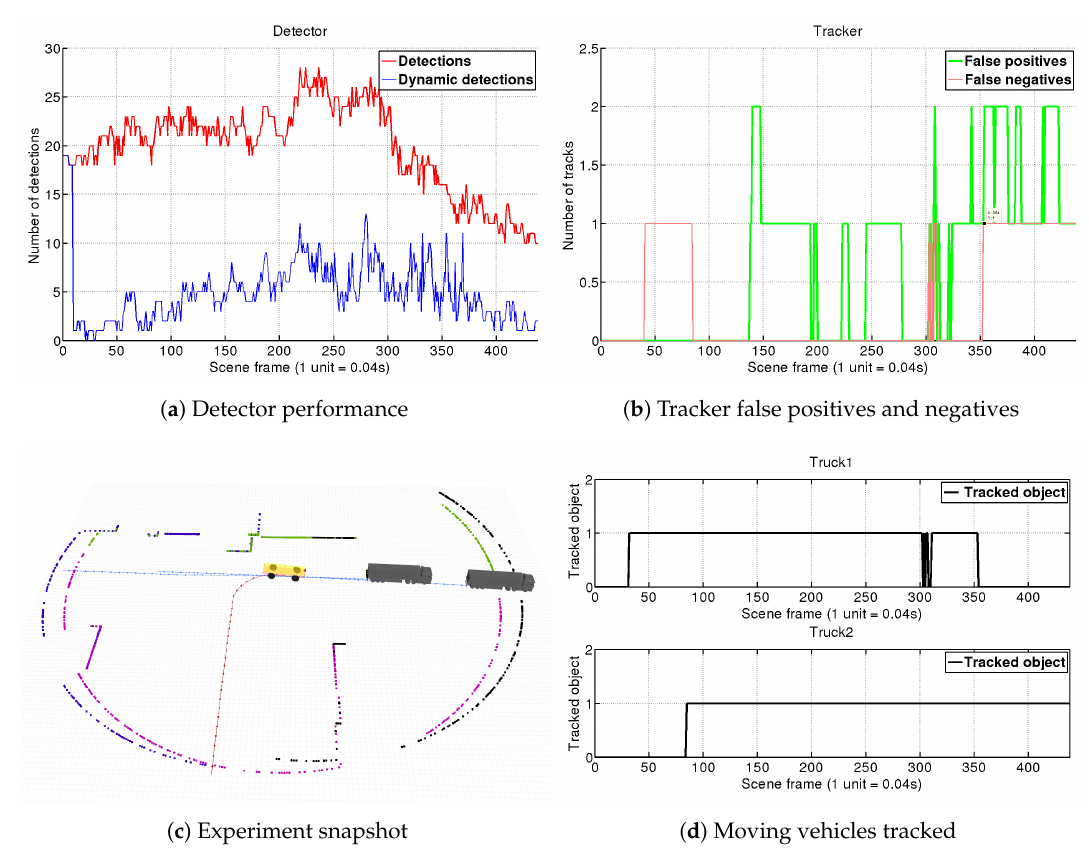
Figure 12. Scene 3. The AGV turns right to join a truck platoon, which is a situation of special interest in the autonomous transportation context. This simulation, performed with a FOV of 360 ◦ , shows the capacity of our DATMO system to quickly filter real moving obstacles from all the objects detected so that reducing by a quarter the computational burden of the